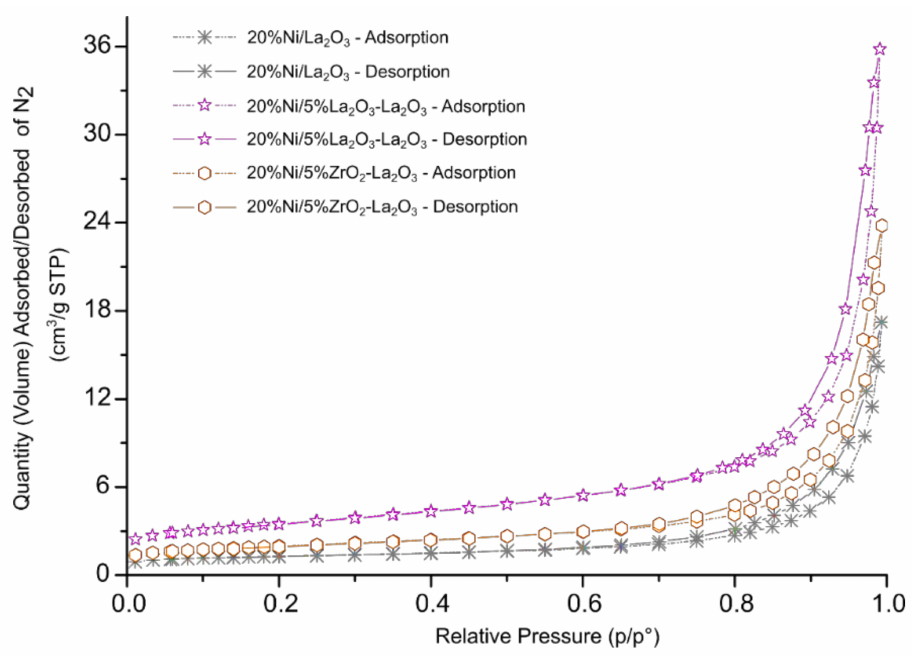
Figure 2. Nitrogen adsorption–desorption isotherms for 20% Ni/La 2 O 3 , 20% Ni/5% CeO 2 –La 2 O 3 and 20% Ni/5% ZrO 2 –La 2 O 3 catalysts calcined in an air atmosphere at 400 ◦ C for 4